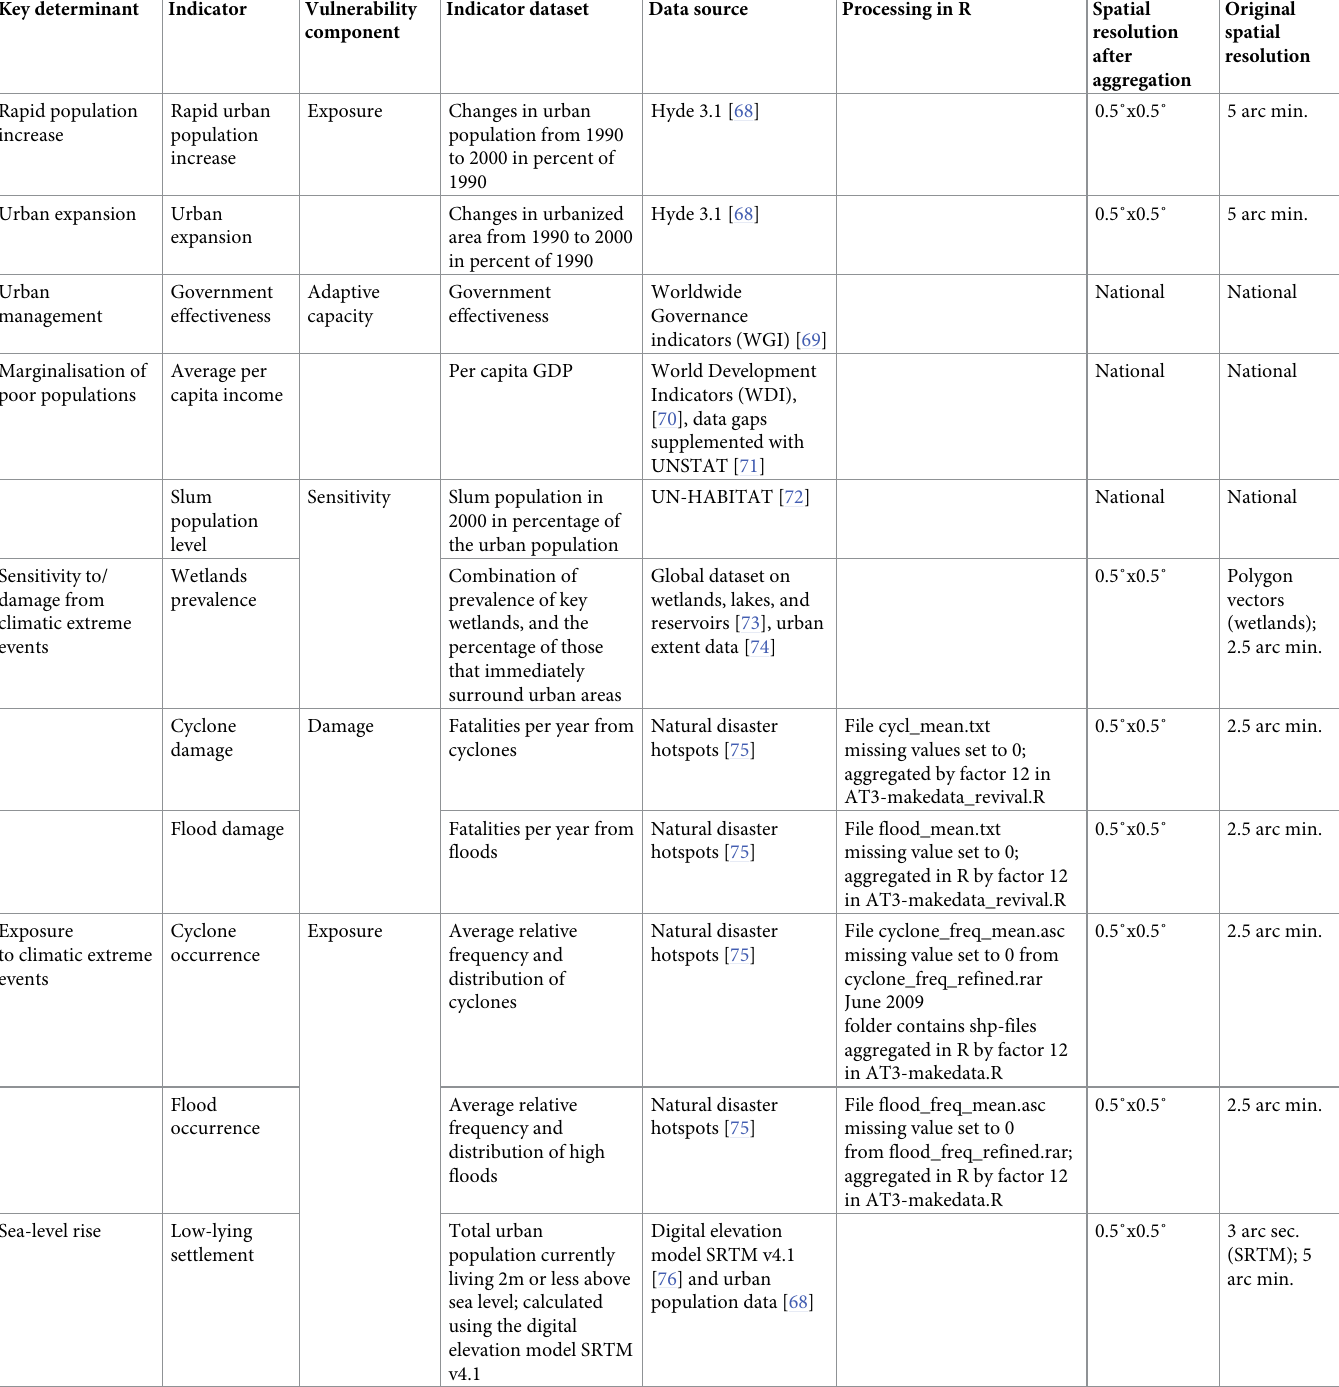
Table 1. Indicators and indicator datasets used, including their assignment to vulnerability components, the key determinants they are related to, and the level of spatial data